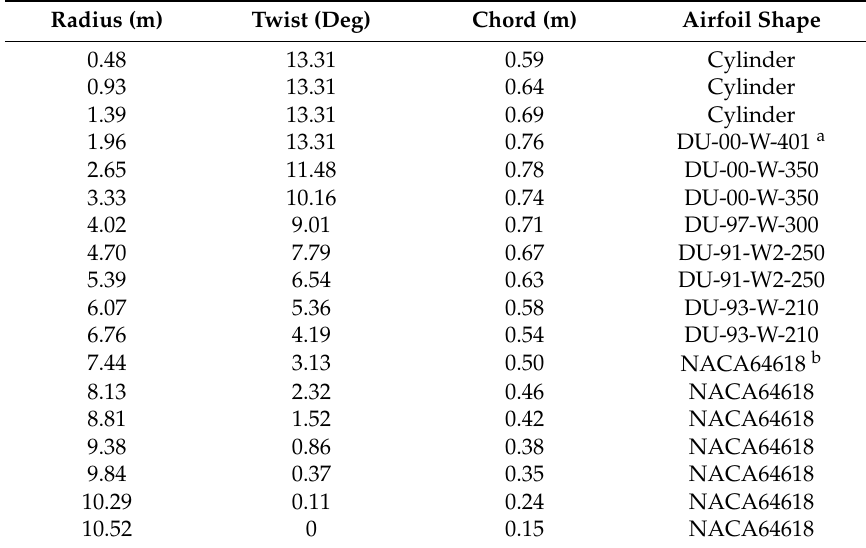
Table 2. Parameters for each section along the blade based on 5 MW prototype wind turbine scaling to blade length of 10.52 m